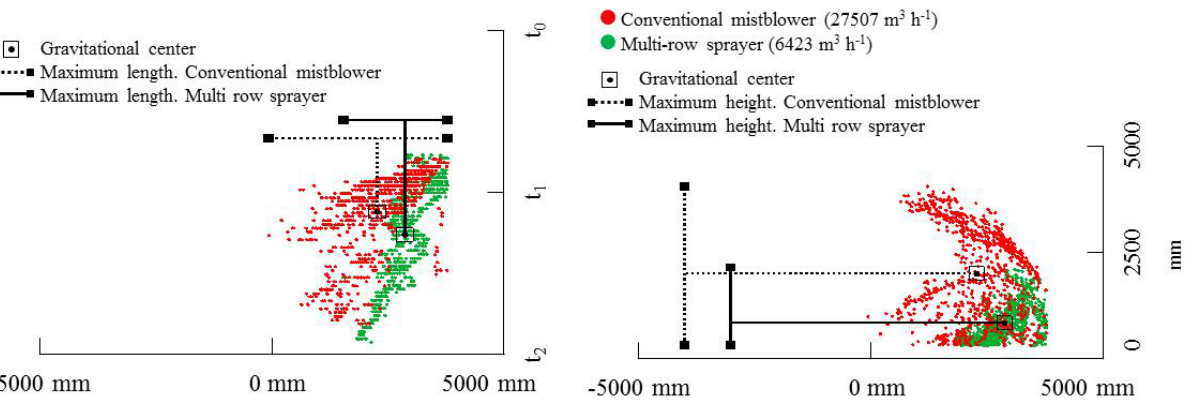
Figure 9. Plan ( left ) and elevation view ( right ) of drift cloud measured with LIDAR comparing conventional mistblower (red) and multi-row sprayer (green) both equipped with conventional nozzles and using low air flow rates. Maximum height, maximum length and gravitational center point are also represented for the LIDAR impacts’ cloud Note that 0 mm in X-axis represents the LIDAR